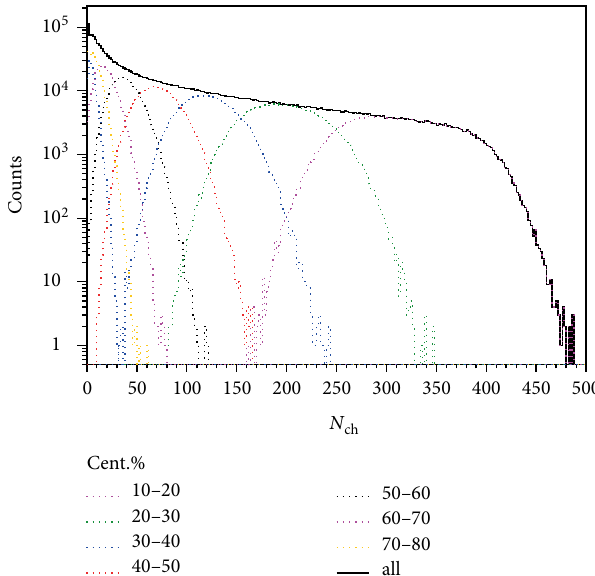
Figure 5: Multiplicity distributions of relativistic charged particles for various centrality classes at 40A GeV in the range 𝑝 GeV/c and 󵄨󵄨󵄨󵄨𝜂 󵄨 󵄨󵄨󵄨 = 1.0 .